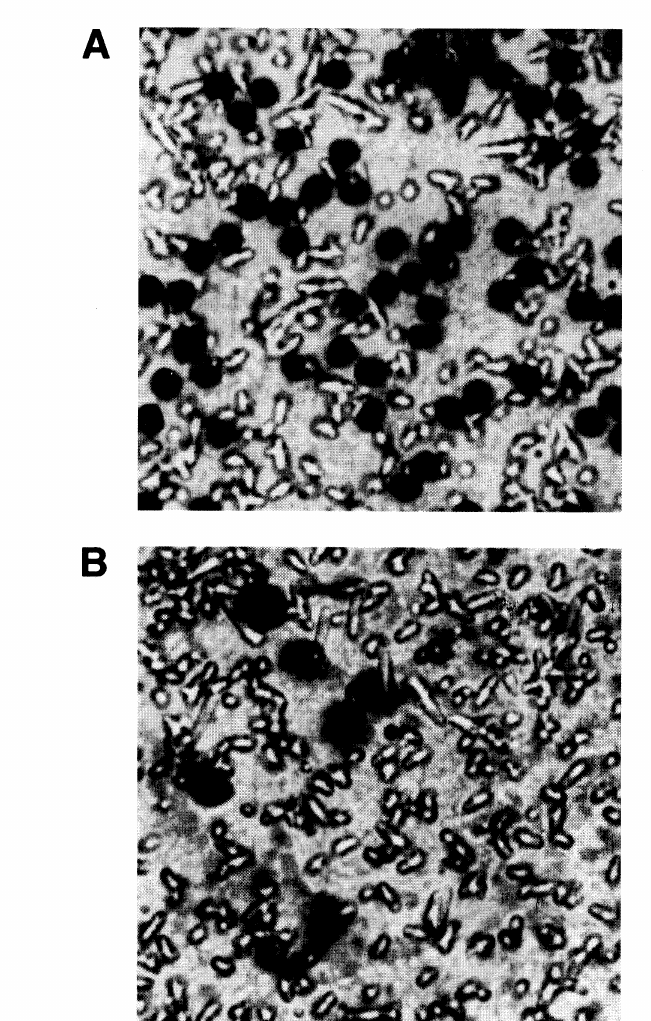
Fig. 4. (A) Control (untreated) PMN migration. Migra- tion pattern of untreated PMN across the polycarbonated membrane was observed by staining the filter with Giemsa. The stained membrane was placed on a glass slide with an oil drop and a coverslip and observed under light micros- copy. Clear channels represent the pores present in the membrane. (B) Migration of gliotoxin-treated (I pg/mL) PMN. PMN crossing the polycarbonate membranes were quantitated and plotted for each of the donors participating in this study.